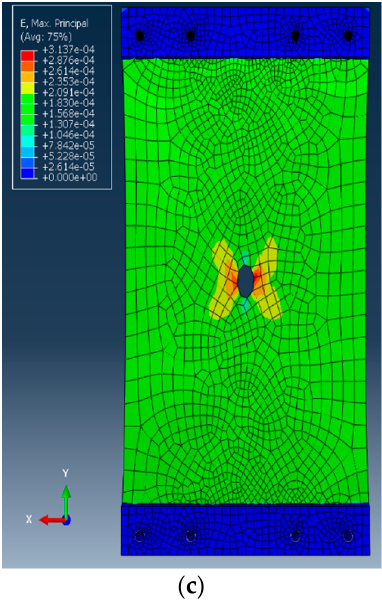
Figure 5. The FE results for different damage states. ( a ) Intact plate ( b ) damage sates (DS)1 (D = 12.7 mm), and ( c ) DS2 (D = 25.4 mm).